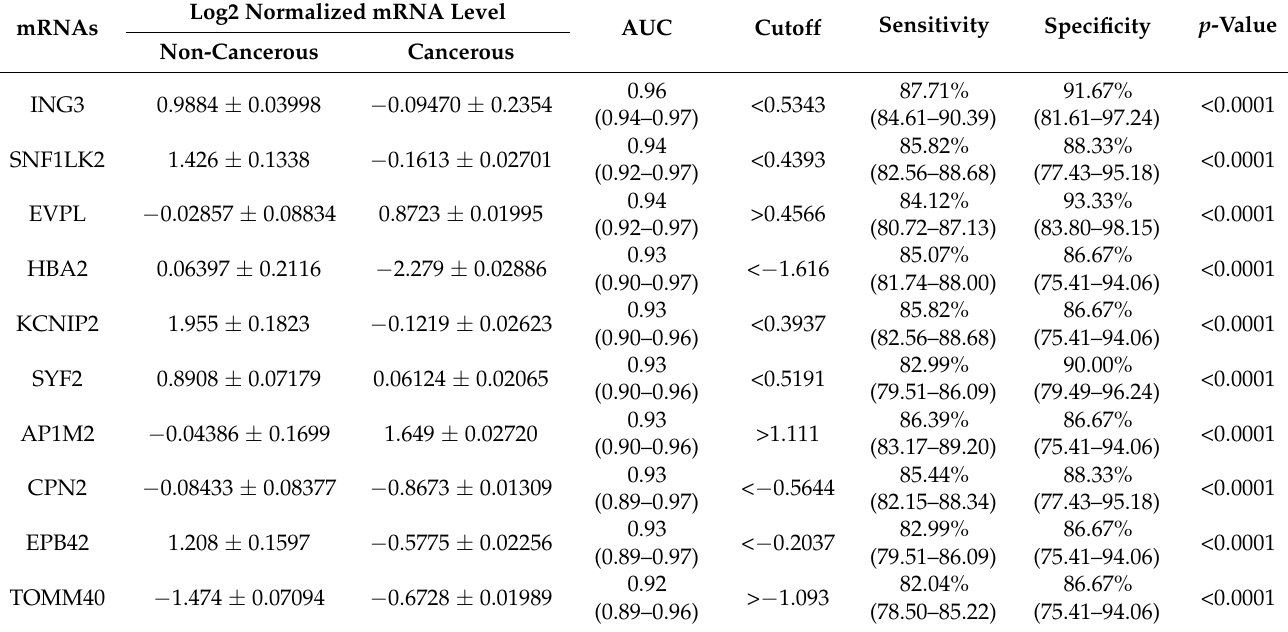
Table 2. Clinical diagnostic performance of 20 mRNAs differentially expressed in breast